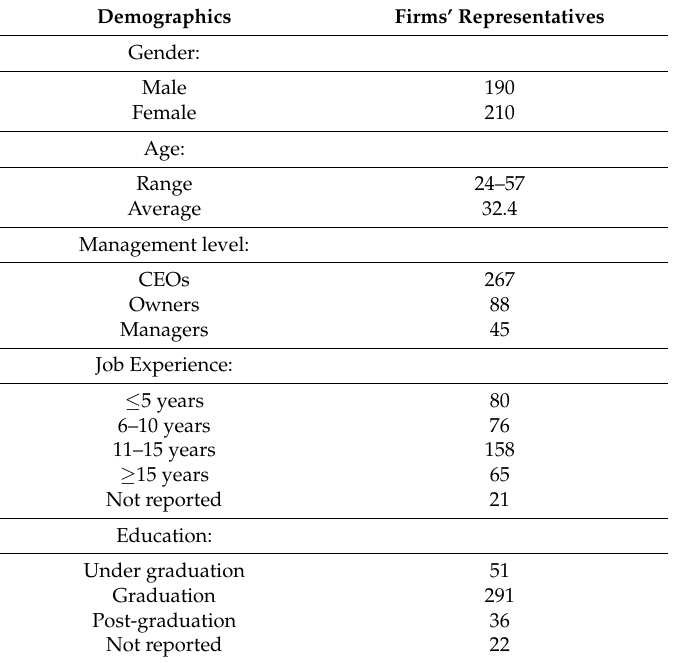
Table 2. Representatives’